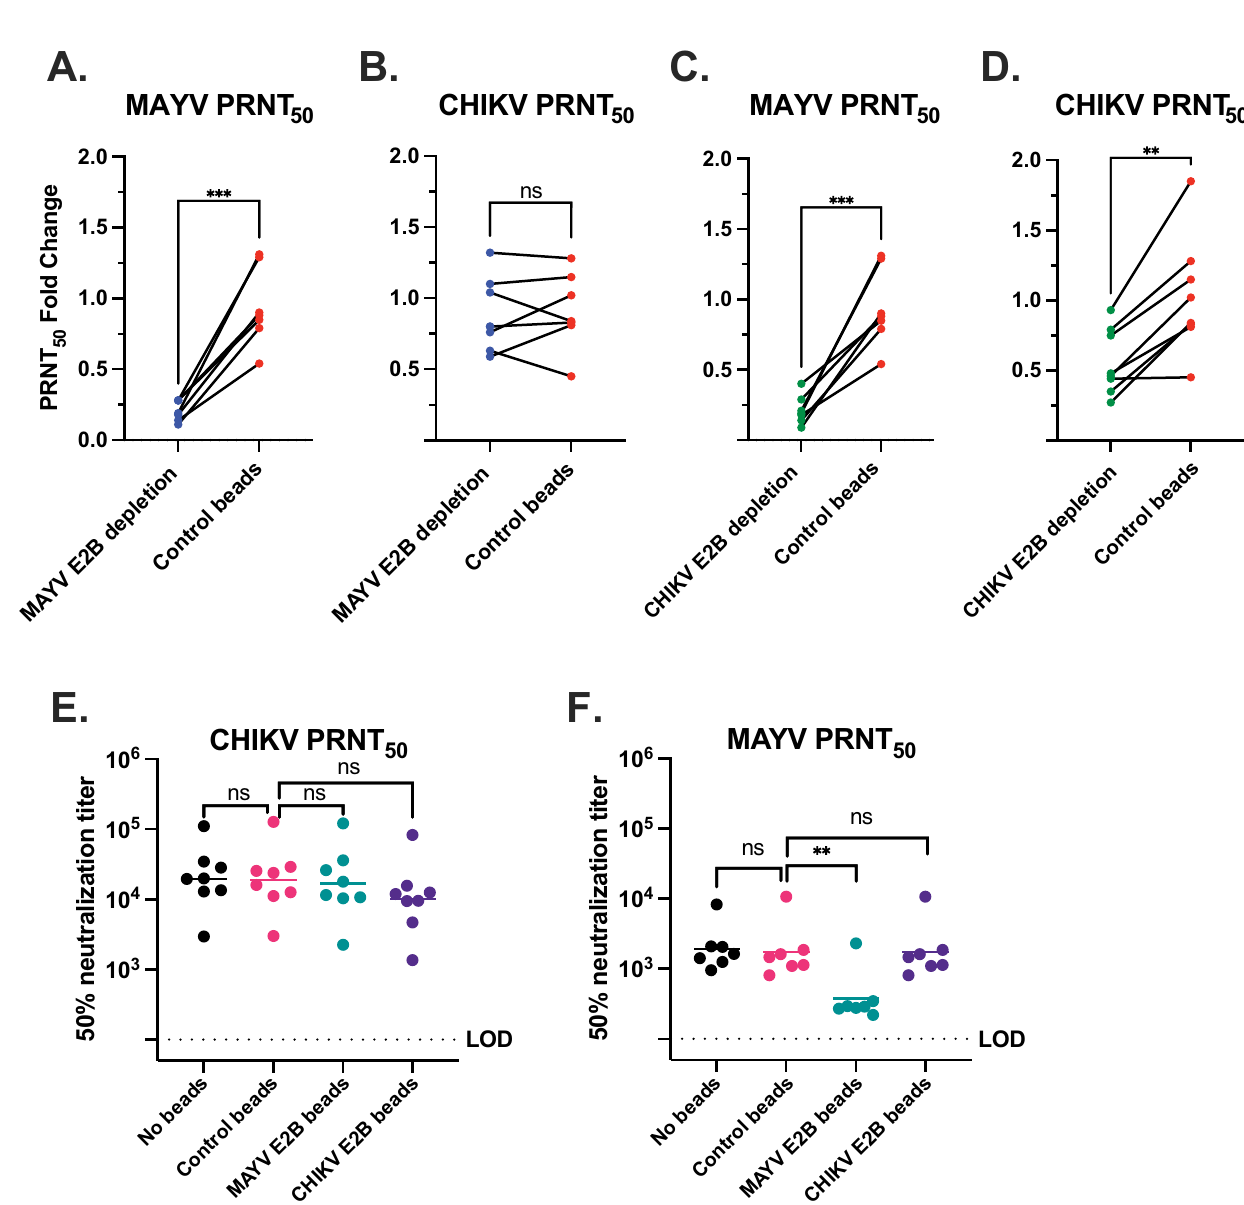
Fig 5. Analysis of changes in CHIKV and MAYV neutralizing antibody titers following E2 B domain depletion. Fold change in neutralizing antibody titers (nAb) of subject serum samples following adsorption against E2B domain coated Ni-NTA or control beads was calculated against non-bead-treated serum samples. Depletion of MAYV E2 B domain-specific antibodies and impact on (A) MAYV or (B) CHIKV neutralizing antibody titer fold change compared to serum with control beads. A paired t-test for comparison of fold change heterotypic MAYV neutralization following MAYV E2B depletion yielded a p value ��� = 0.0003 and 0.3276 (ns) for homotypic CHIKV neutralization. Depletion of CHIKV E2 B domain-specific antibodies and impact on (C) MAYV or (D) CHIKV neutralizing antibody titer fold change compared to serum with control beads. A paired t-test for comparison of fold change in heterotypic MAYV neutralization following CHIKV E2B depletion yielded a p value ��� = 0.0006 and �� 0.0013 for homotypic CHIKV neutralization. Comparison of changes in (E) CHIKV PRNT 50 or (F) MAYV PRNT 50 following E2B depletion relative to no beads or control samples. LOD = 100 with values below the limit of detection graphed as 99. Data were analyzed using a one-way ANOVA with the significant comparison in (F) being �� p = 0.0045. Note Subject 17 was excluded from this statistical analysis as the MAYV neutralization in this subject was low, therefore, the impact on E2B depletion was not